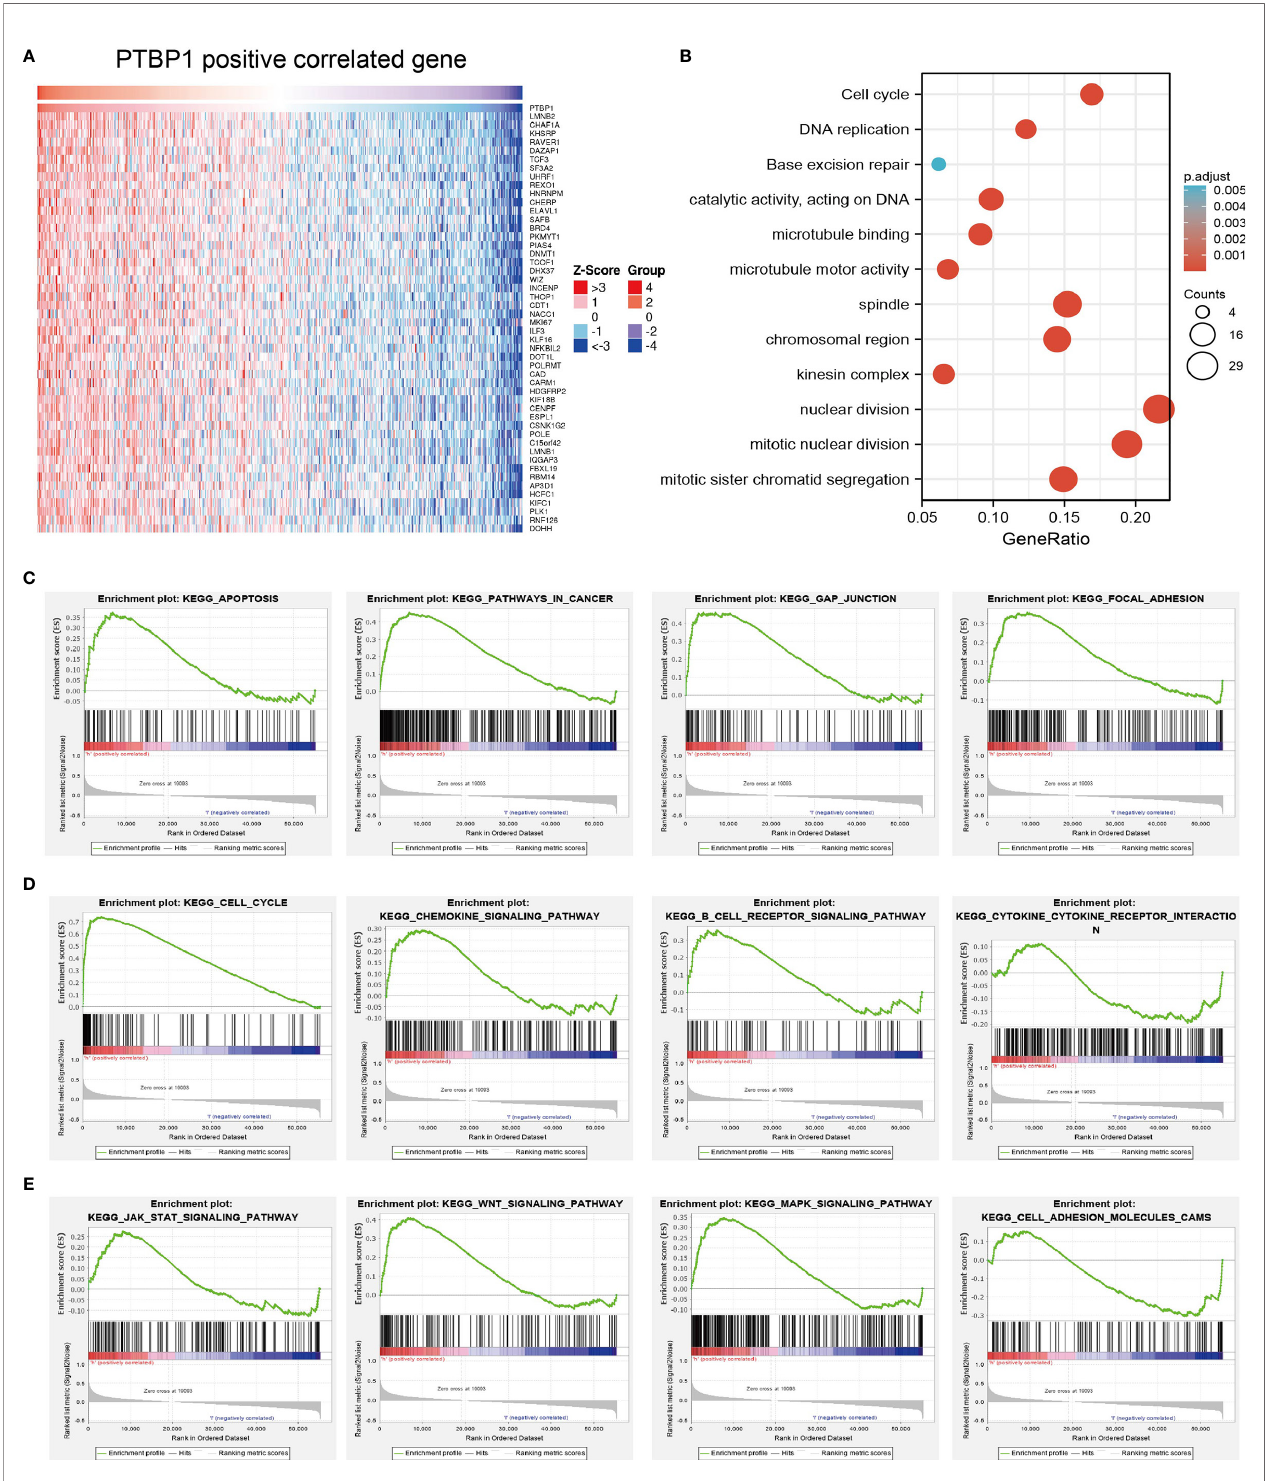
FIGURE 10 | Analysis of the function of PTBP1 in LUAD. (A) The positive gene of PTBP1 in lung cancer analysis by employed the Linkedomics tools. (B) The KEGG signaling pathway of PTBP1 in lung cancer. (C – E) The involvement of genes co-expressed with PTBP1 in LUAD signaling pathways as examined by GSEA